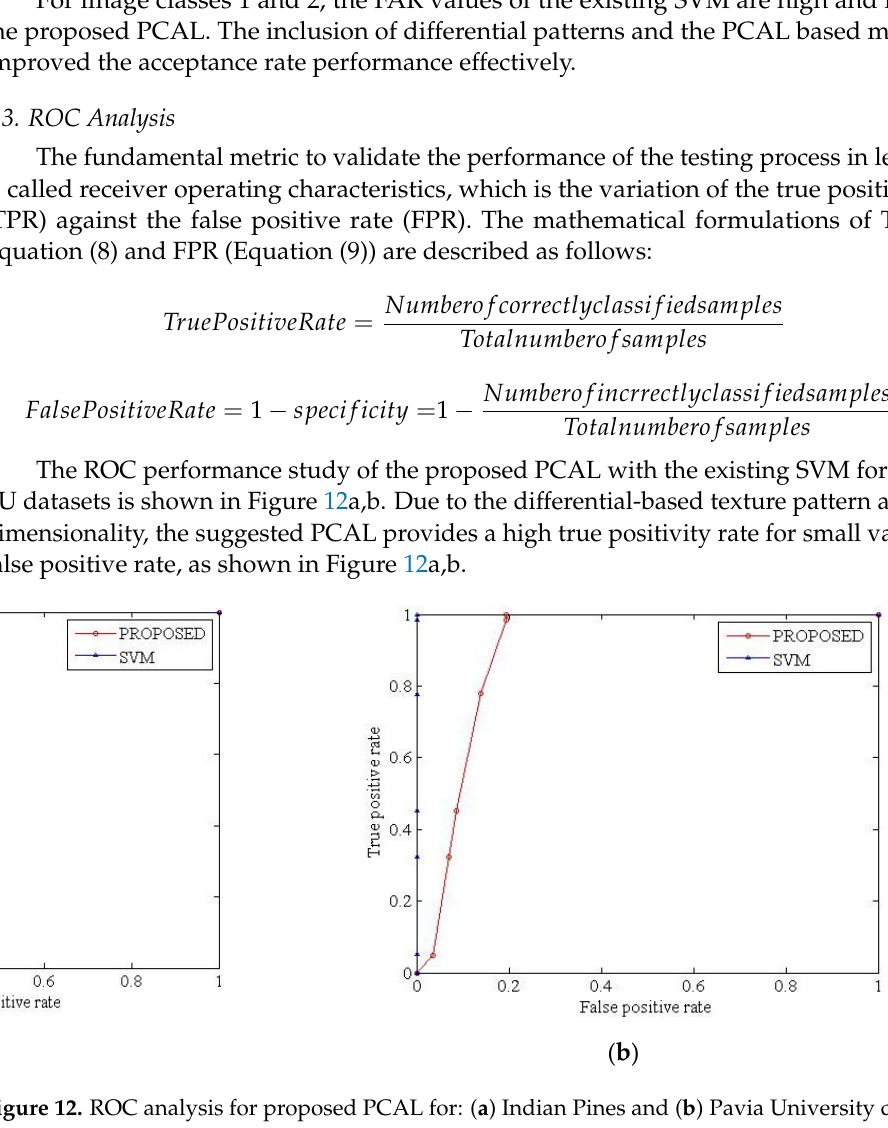
Table 6. Overall accuracy.